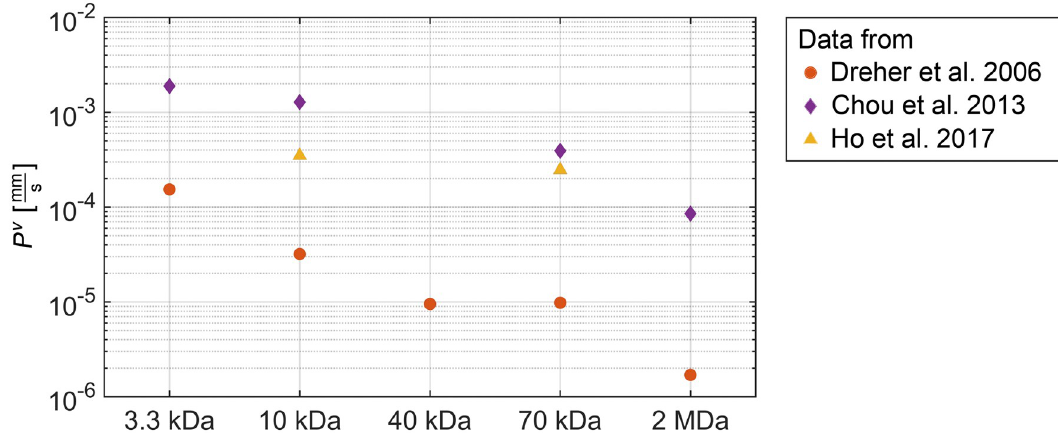
Fig 7. Values for the vascular permeability coefficient. Vascular permeability coefficient P v of dextrans with a molecular weight of 3.3 kDa, 10 kDa, 40 kDa, 70 kDa and 2 MDa summarised from data by Dreher et al. [54], Chou et al. [55] and Ho et al. [53].